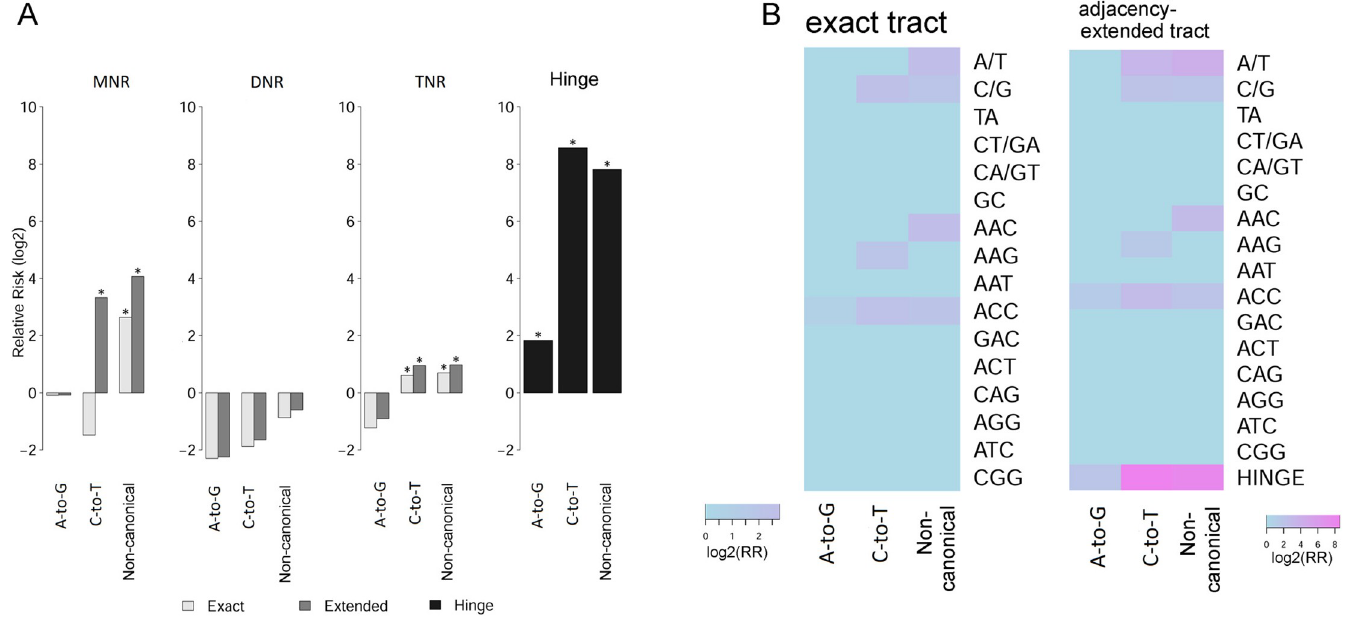
Fig 4. Non-canonical RNA-DNA differences are enriched within polytracts and, more markedly, break-points (hinges). A, A-to-G and C-to-T editing events do not have a higher likelihood of appearing in MNRs, whereas non-canonical events do; A-to-G, C-to-T, and non-canonical RNA-editing events all have a higher likelihood of appearing in polytract hinges. Exact , exact regions of polytract occupancy. Extended , polytracts extended with one neighboring nucleotide bi-directionally. Hinge , single- nucleotide sites located between two neighboring stretches of exact polytracts. Asterisk ( � ), binomial enrichment p < 0.01. B, heatmap of Relative Risk (RR) of polytract bearing an RNA-editing event, depicted for combinations between editing event classes and polytract species. Non-elevated relative risks (RR < 1) or statistically insignificant (p > 0.01) associations of editing events were imputed with RR = 1.